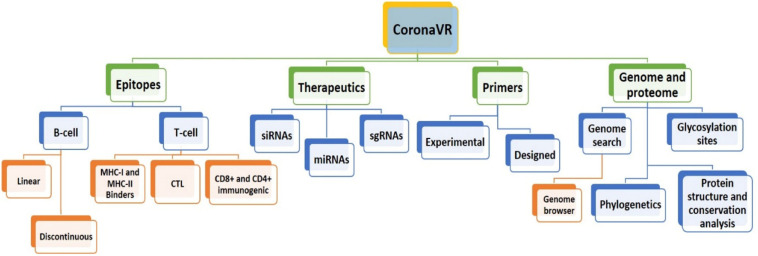
Architecture of the CoronaVR compendium.